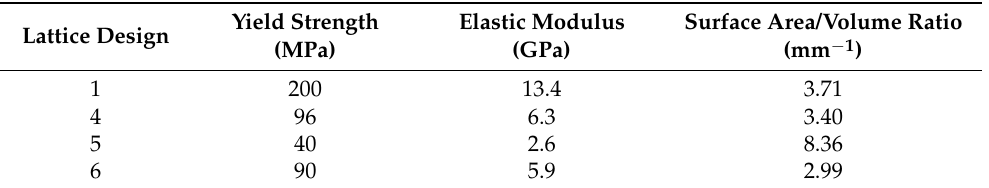
Figure 8. Stress vs. strain curves obtained from FEA: ( a ) Lattice 1; ( b ) Lattice 4; ( c ) Lattice 5; ( d ) Lattice 6. Table 4. FEA results for the mechanical properties and surface area/volume ratios of different lattice structures.